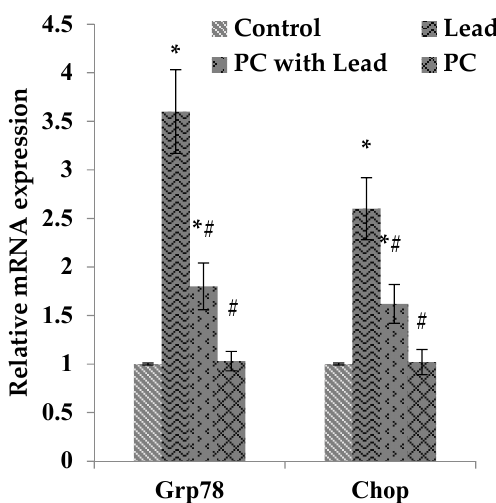
Figure 7. The effect of proanthocyanidins (PCs) on the protein expression levels of GRP78 and CHOP protein in liver tissues of mice exposed to lead. ( A ) GRP78; and ( B ) CHOP. All results are expressed as the mean ± SE ( n = 7). * p < 0.05, significant change with respect to the control; # p < 0.05, significant change with respect to lead ‐ treated mice.